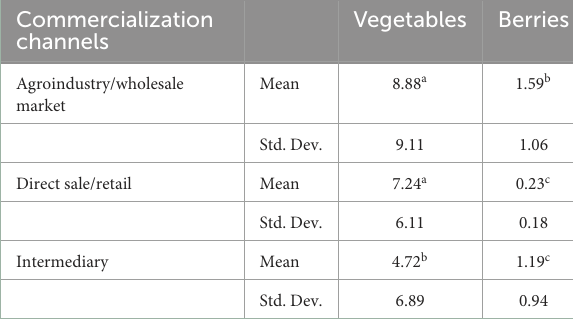
TABLE 5 Food loss (ton/ha) estimated in the main crop according to commercialization channels. Commercialization channels